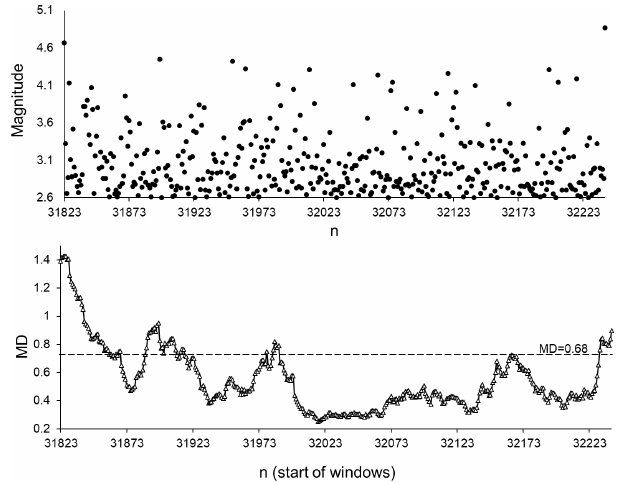
Figure 14. Magnitudes and MD values calculated for the non- aftershock part of the SC catalogue from 7 April 2011 (sequential number in SC catalogue 31823) to 14 February 2012 (sequential number in SC catalogue 32240). Average MD values are calculated for 50-data windows shifted by one data step.